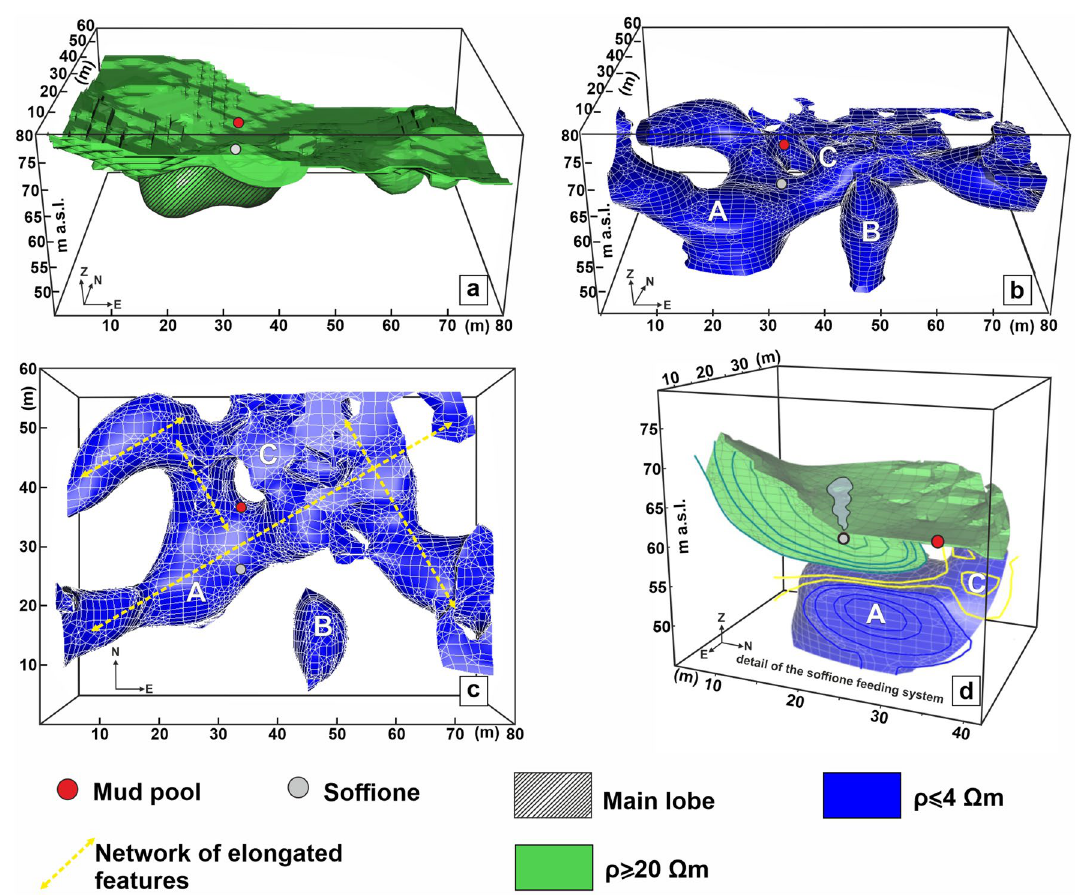
Figure 3. Details of the HRV and the LRV sketched in Fig. 2. The features discussed in the text are labeled with capital letters. The yellow dotted lines in panel ( c ) indicate the main alignments of the elongated branches that cross part of the LRV. The figure was created by the Visit 3.1.2 (https:// wci. llnl. gov/ simul ation/ compu ter- codes/ visit) open-source software produced by the Lawrence Livermore National Laboratory (USA) and postprocessed using the Corel Draw 17 commercial software (https:// www. corel draw. com/ it/ produ ct/ corel